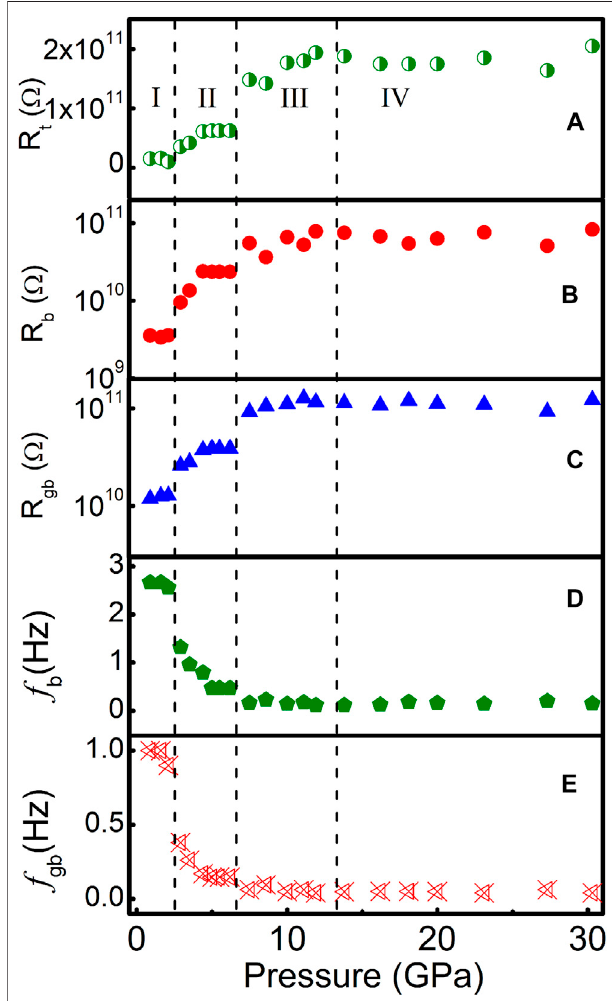
FIGURE 5 | Pressure dependencies of (A) R t , (B) R b , (C) R gb , (D) f b, and (E) f gb of phenanthrene.